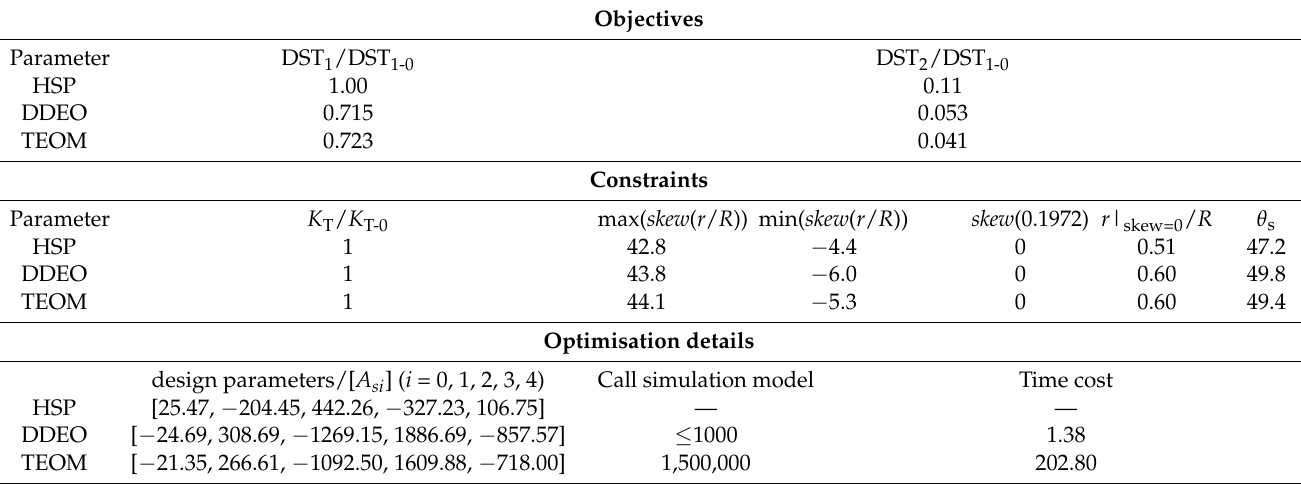
Table 5. Results of